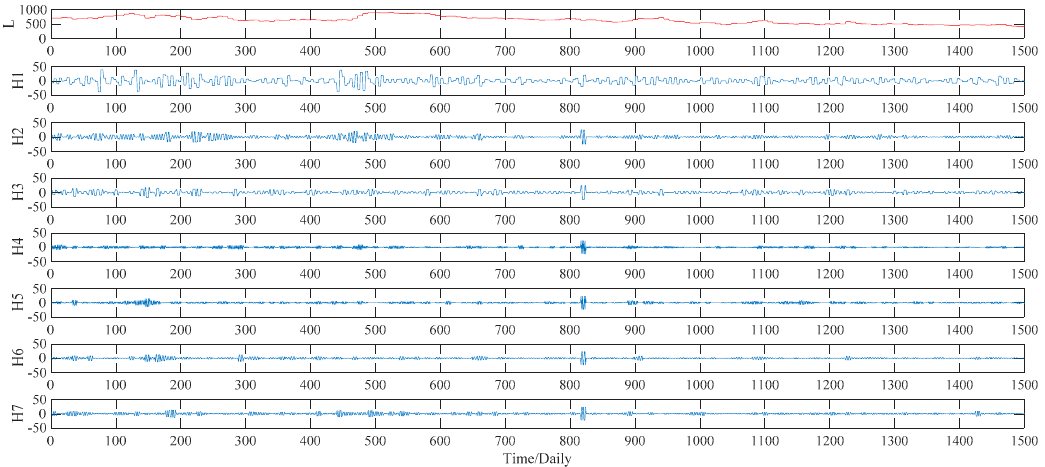
Figure 8. Decomposition results of the WPT method (wheat).